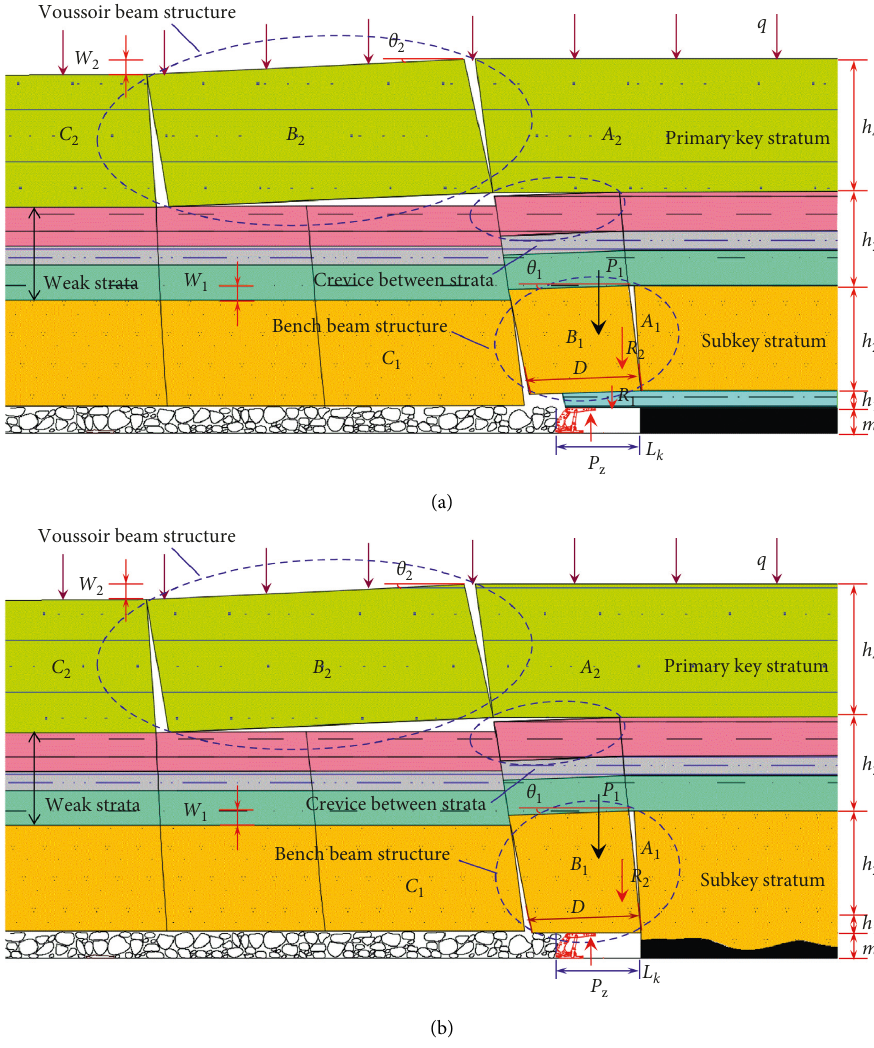
Figure 9: Mechanical model of the roof during the extraction of supports. (a) Outside the eroded area. (b) Inside the eroded area.